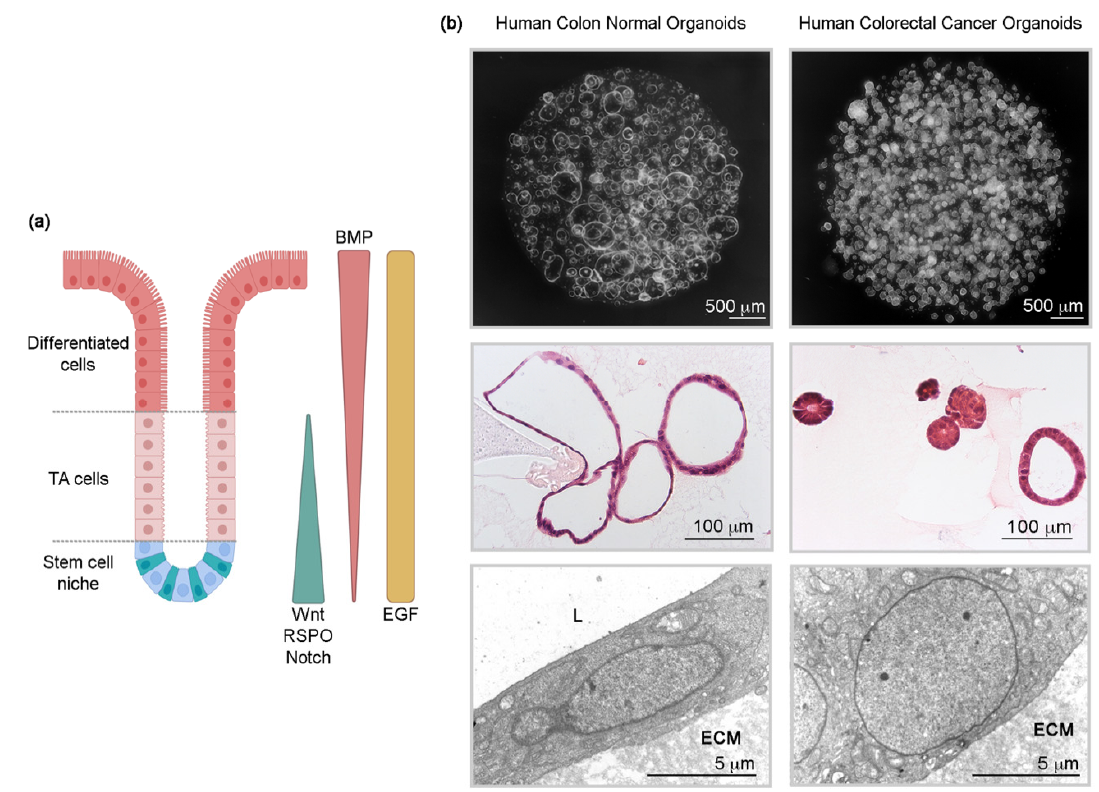
Figure 1. ( a ) Scheme of a colon crypt including some of the niche factors controlling cell fate. TA cells, transient-amplifying cells. Created with Biorender.com (accessed on 27 April 2021). ( b ) Morphology of human colon normal (PDO) and tumor (PDTO) organoids. Upper panels: light microscopy images. Middle panels: hematoxylin and eosin (H&E) staining. Lower panels: electron microscopy images showing the common undifferentiated phenotype of cells in both types of organoids (decondensed euchromatin, lack of villi, scarce cytoplasmic organella). ECM, extracellular matrix (Matrigel); L, lumen. Images shown are unpublished and correspond to studies by our group.